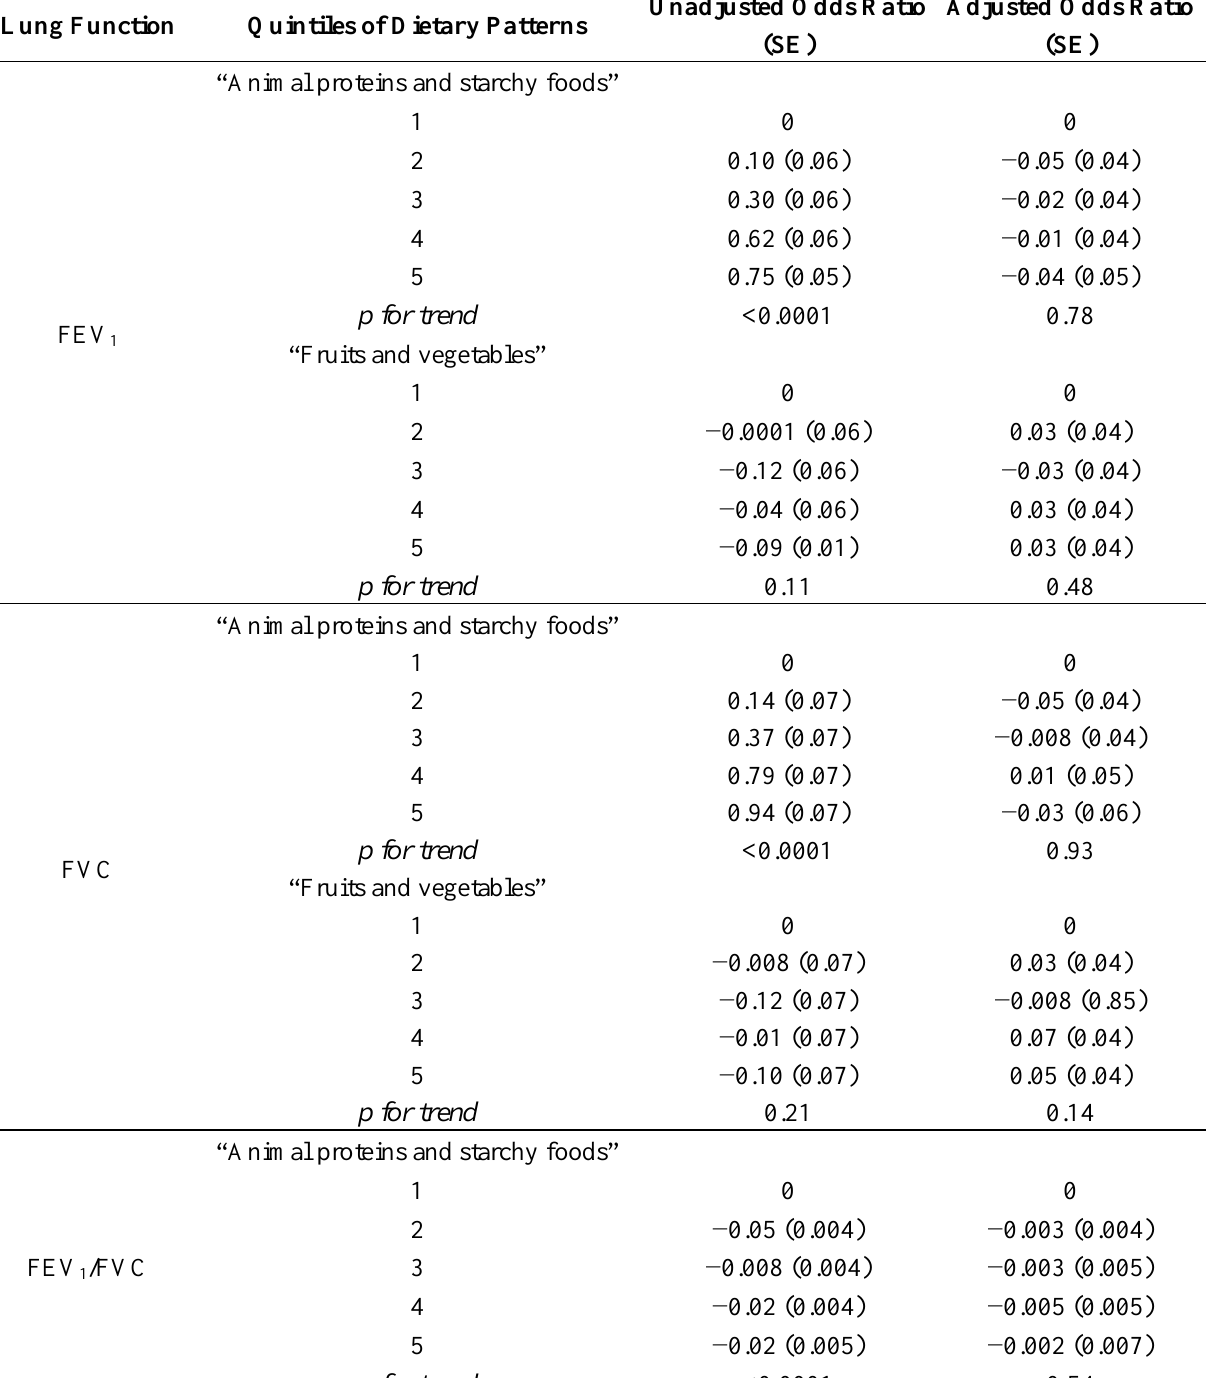
Table 5. Association between quintiles of dietary patterns and ventilatory capacity *. Lung